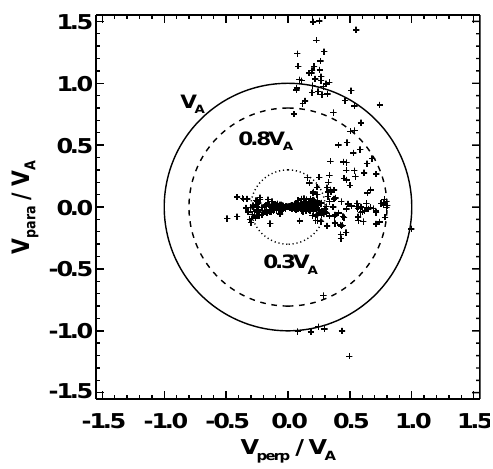
Fig. 10. Friedrichs diagram of magnetosheath wave events. The radii of the circles denote the phase velocities 0 . 3 V A (dotted), 0 . 8 V A (dashed) and V A (solid).